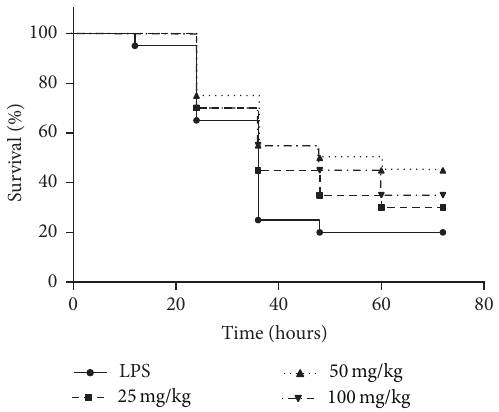
Figure2:EffectsofAC-RsvonLPS-inducedmortalityinmice.Mice from each experimental group were injected with 20 mg/kg of LPS with or without pretreatment of AC-Rsv (25, 50, and 100 mg/kg) for 7 days. Alive mice in each group were counted every 12 h. The accumulative mortalities of mice in middle-dose (50 mg/kg) and high-dose (100mg/kg) groups were 55% and 65%, respectively, which were significantly lower than that of LPS group (80% mice dead) ( 𝑃 < 0.05 ). More importantly, 50 mg/kg of AC-Rsv exhibited the best protecting effect, 𝑃 < 0.05 , 𝑛 = 20